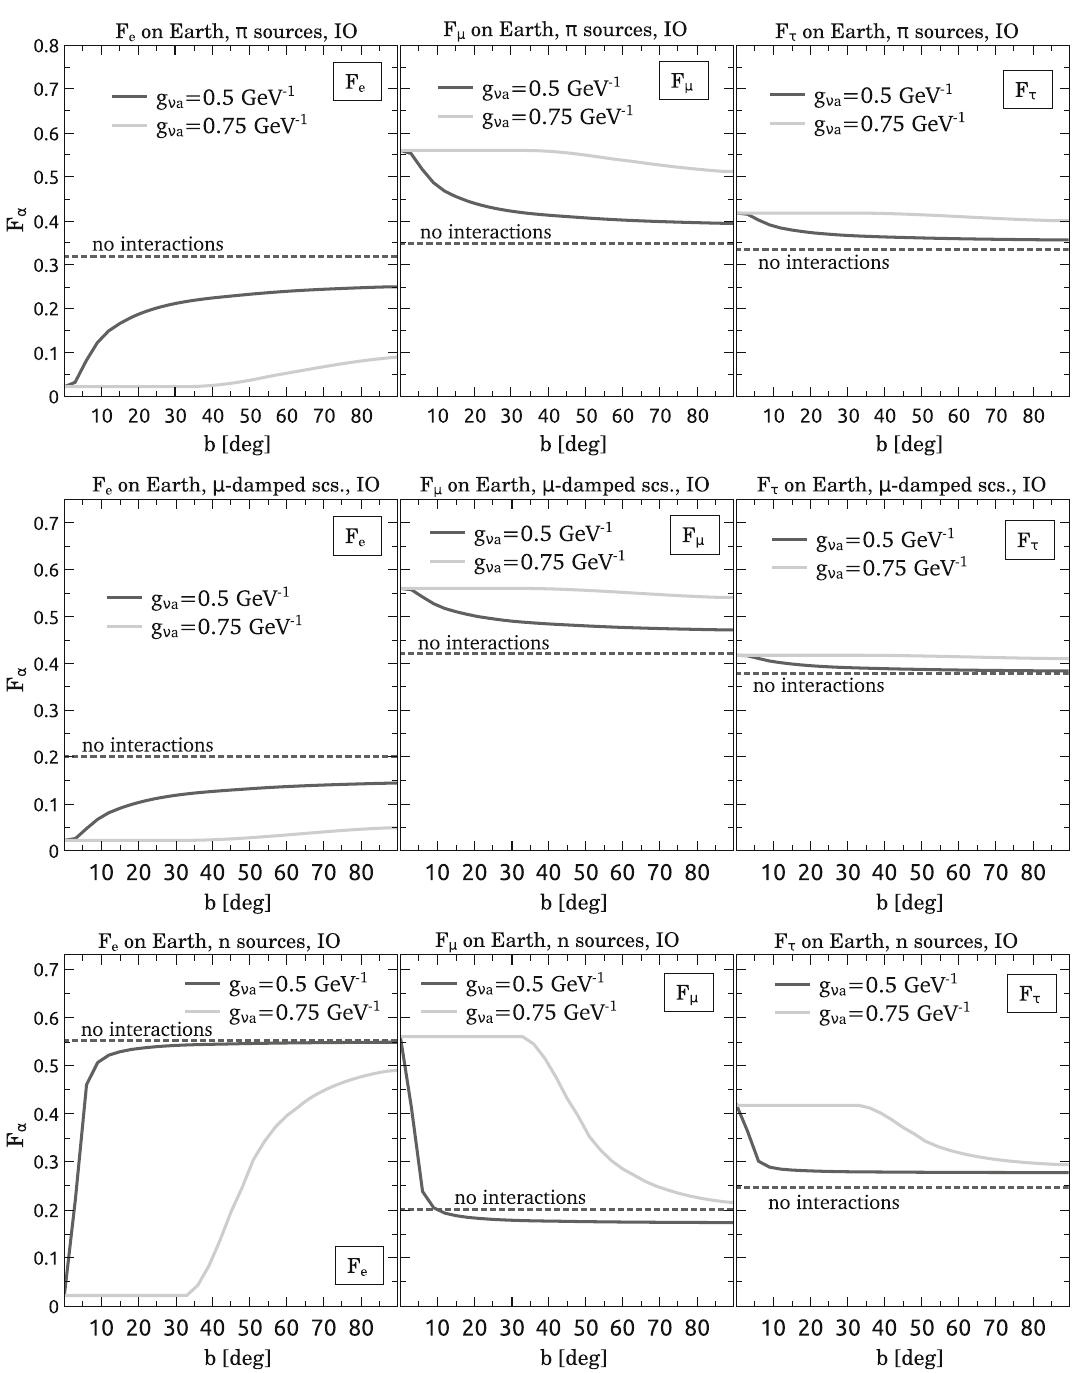
vor ratios are shown in the left, middle, and right panels, respectively. Top panels correspond to pion decay sources, middle panels to muon damped sources, and bottom panels to neutron decay